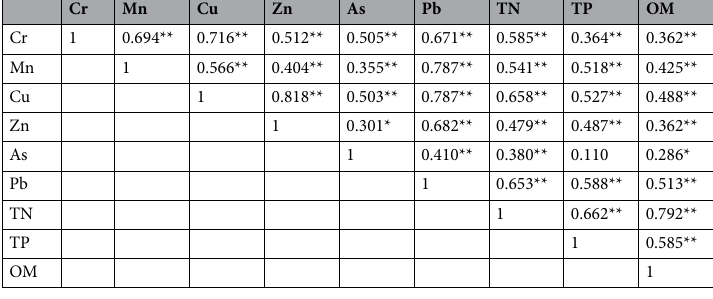
Table 7. Correlation analysis of pollutants in sediments. ** p < 0.01; * p <